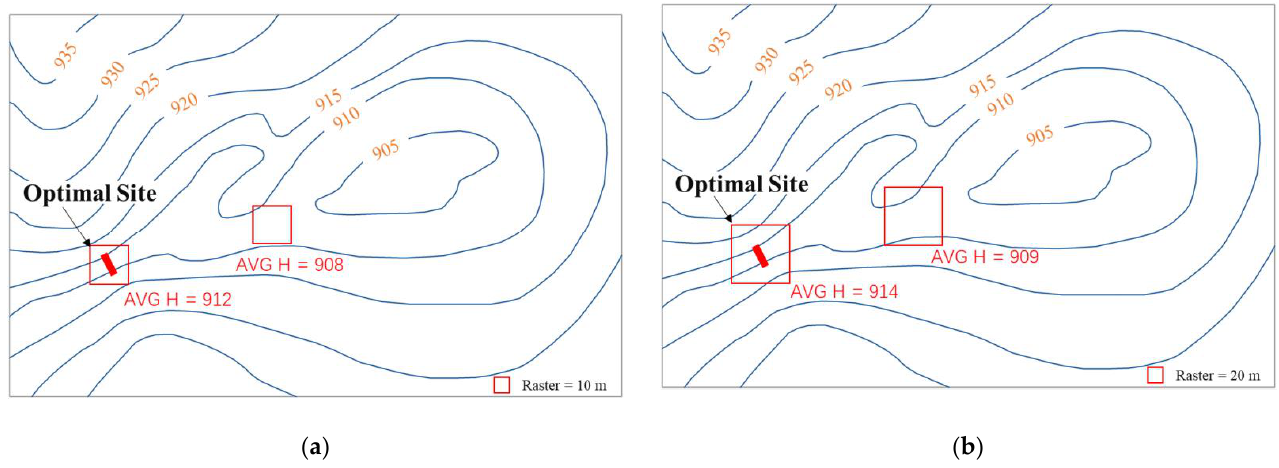
Figure 2. Multi-scale terrain feature-based depression extraction : ( a ) when the raster is 10 m; ( b ) when the raster is 20 m. AVG H = average height.